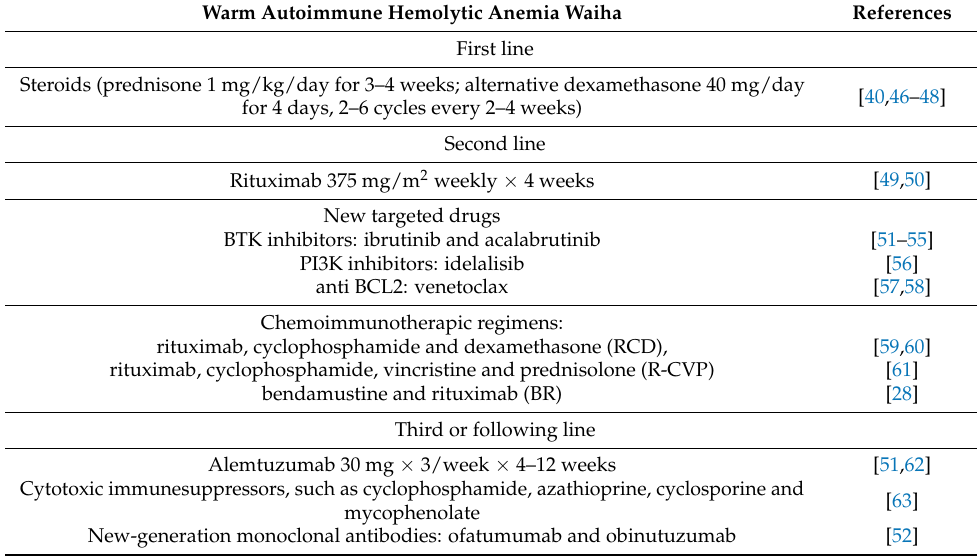
Table 2. Options for treatment of